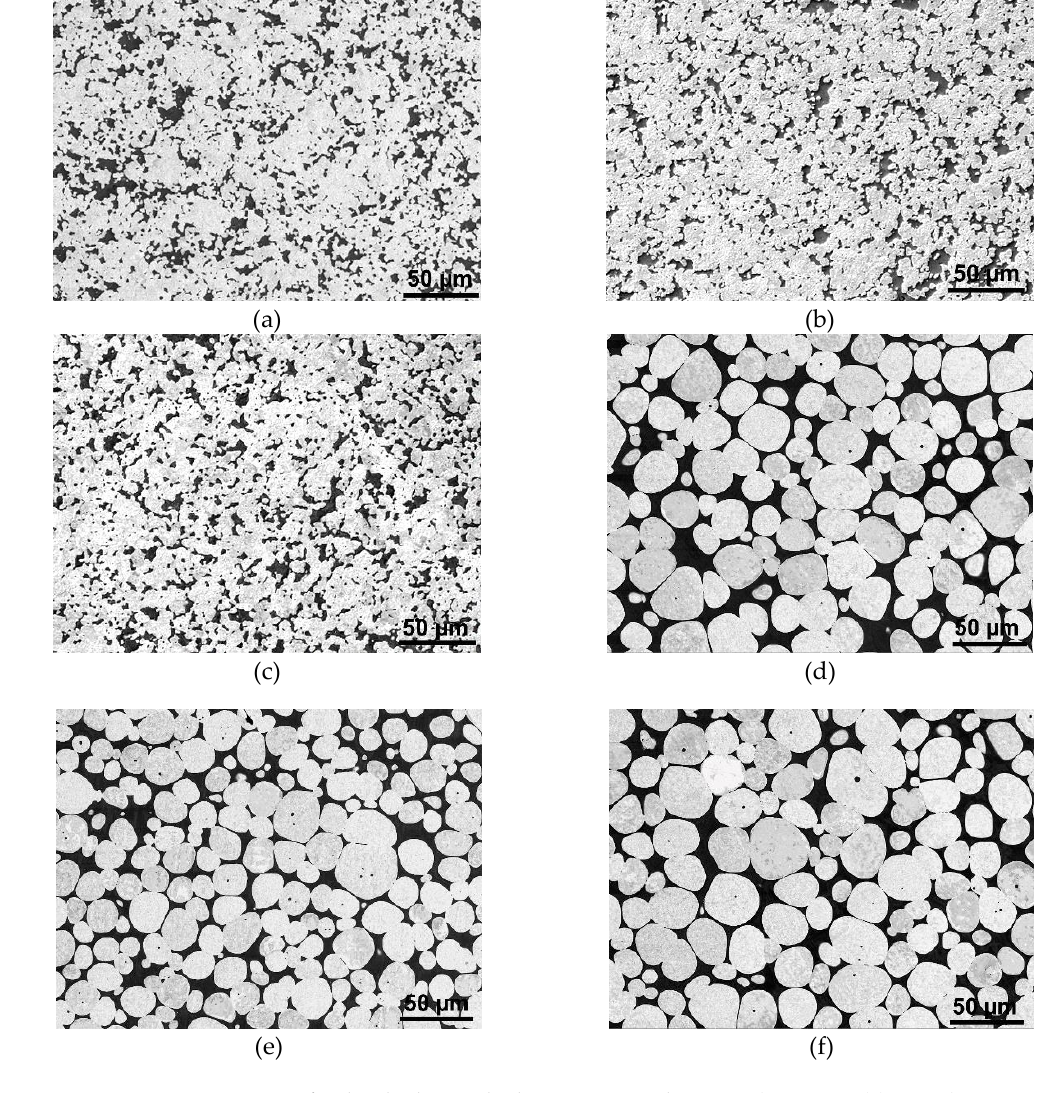
Table 1. Average microhardness for sintered pieces. Sample Sintering Regime Average Microhardness [HV] Standard Deviation 1450 °C/30 min